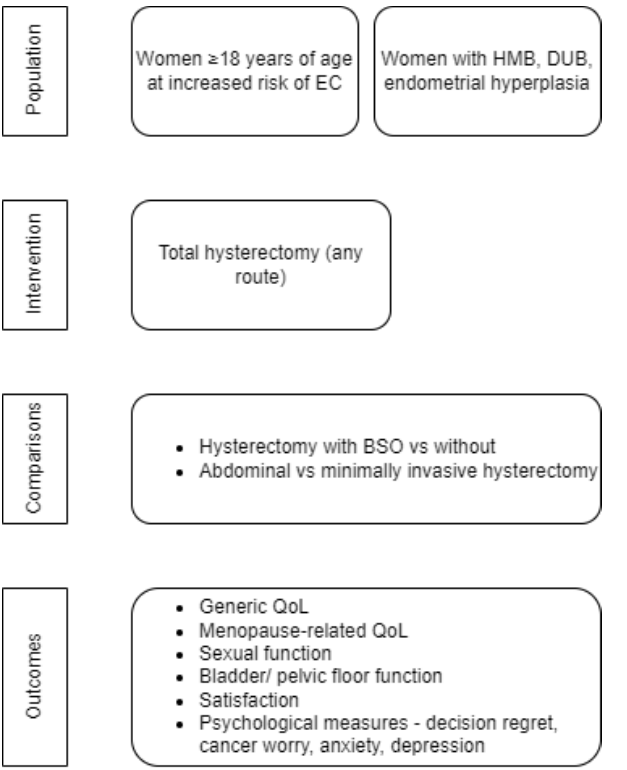
Figure 1. PICO framework of the systematic review. EC, Endometrial cancer; HMB, Heavy menstrual bleeding; DUB, Dysfunctional uterine bleeding; BSO, Bilateral salpingo-oophorectomy; QoL, Quality of Life .